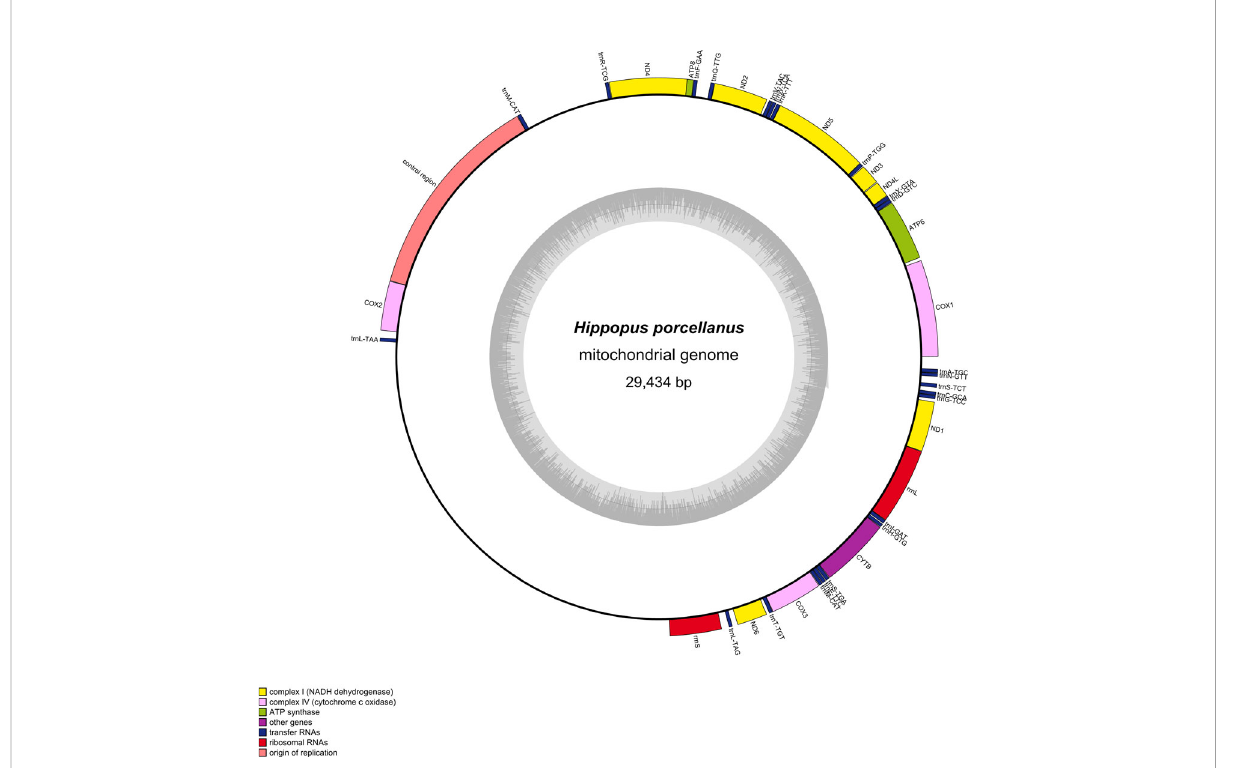
FIGURE 1 The mitochondrial genome map of H. porcellanus